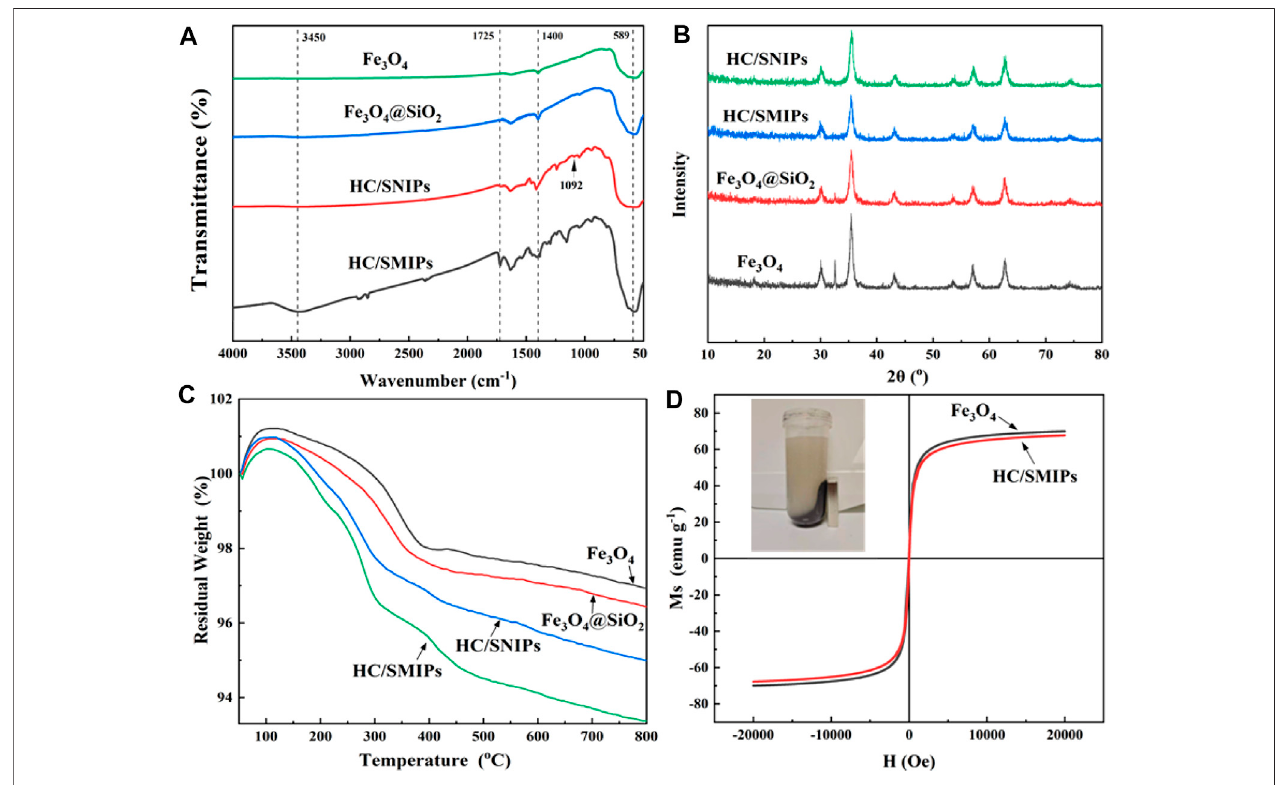
FIGURE 3 | FTIR spectra (A) , XRD spectra (B) and TGA curves (C) of Fe 3 O 4 , Fe 3 O 4 @SiO 2 , HC/SNIPs and HC/SMIPs (D) Magnetic hysteresis loops of Fe 3 O 4 and HC/SMIPs, the inset graph shows the magnetic separation of HC/SMIP in ethanol by a magnet.